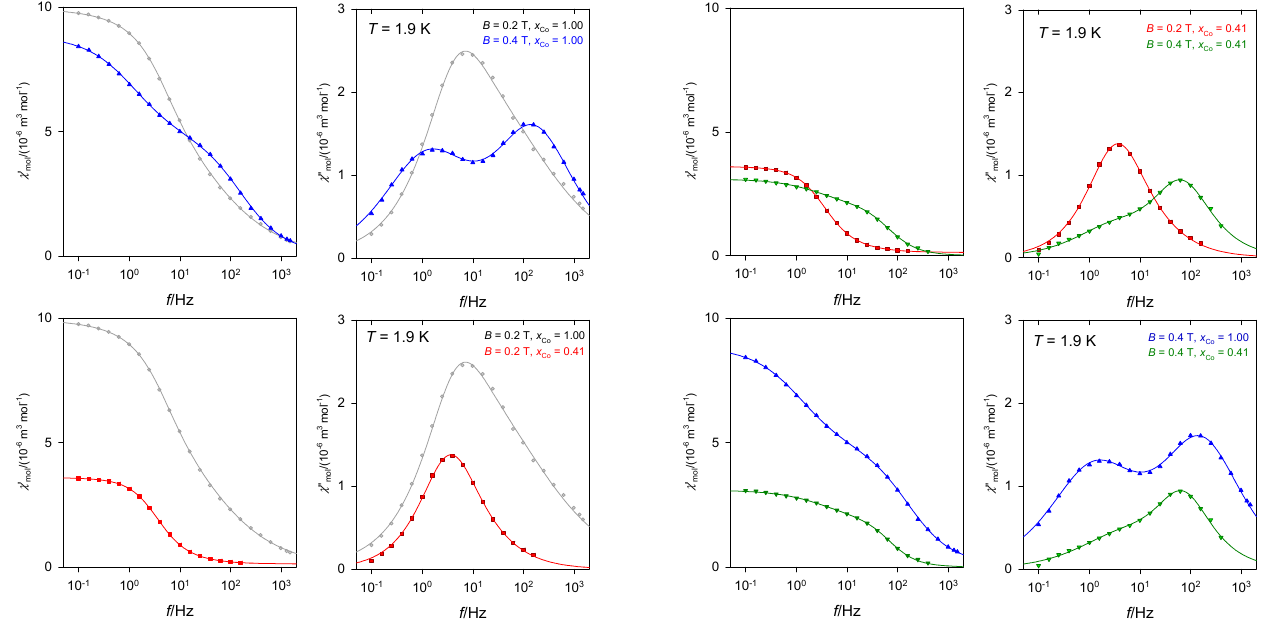
Figure 11. AC susceptibility for a doped sample C 28 H 26 Co 0.52 N 4 O 13 Zn 1.48 ( 2b ). Two hexacoordinate complexes with the same pincer-type structure, [Cu( pydca )( dmpy )] 0.5H 2 O and [Ni( pydca )( dmpy )] · H 2 O, also show RTB [53,54] (Table 3). A complex [Co( dmpy ) 2 ]( dnbz ) 2 ] containing 2,6-pyridinedimethanol in the coordination sphere and dinitrobenzoato anions also shows the slow magnetic relaxation, however, without RTB in the studied region of temperatures and magnetic fields [27]. The ln τ HF vs. ln T dependence gave the temperature exponent l = 2.3 suggesting the phonon bottleneck relaxation process. There is a strong change in the slow magnetic relaxation upon doping to the diamagnetic Zn(II) matrix (Figure 12).